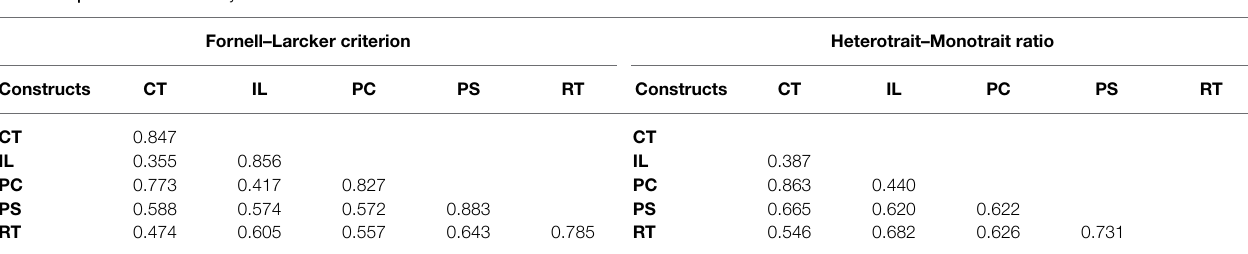
TABLE 3 | Discriminant